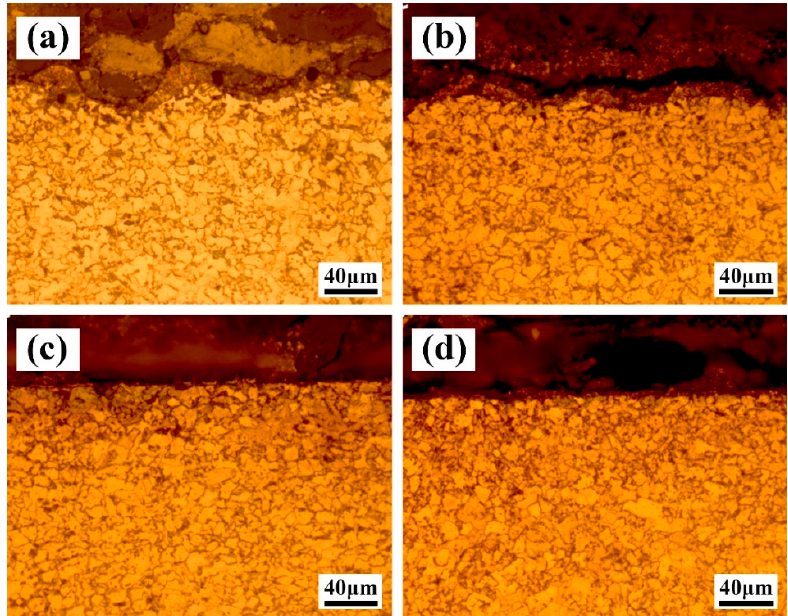
Figure 13. The effect of X-scanning speed on the metallographic structure of the cross-section of the Q345 steel ( a ) 500 mm/s; ( b ) 1000 mm/s; ( c ) 1500 mm/s; ( d ) 2000 mm/s at a Y-moving speed of 7 mm/s after laser cleaning.